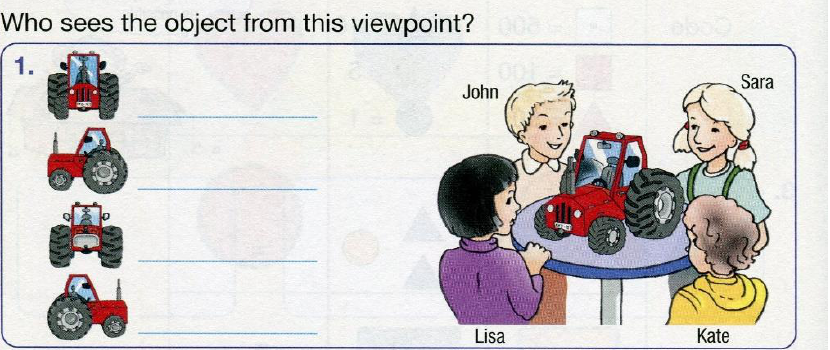
Figure 1. Example of counting problems and visual form from Laskutaito textbooks. Note. From Laskutaito 2B, p.